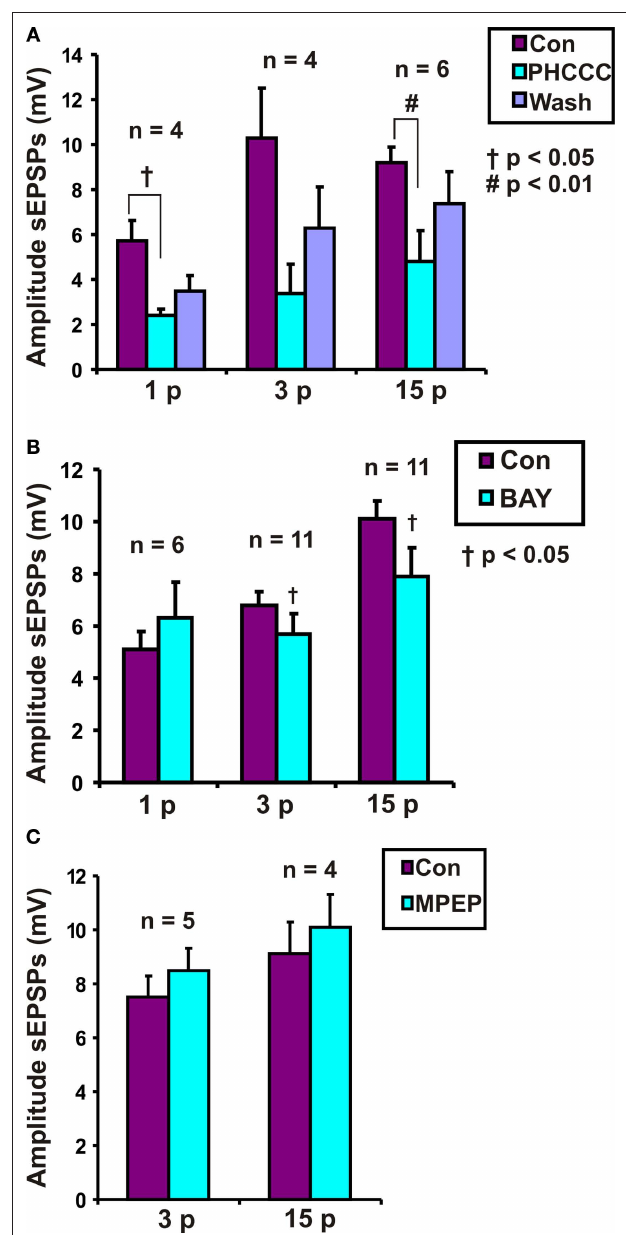
FiGuRE 4 | Effects of (A) PHCCC (30 μM), (B) BAY 36-7620 (10 μM) and (C) MPEP (10 μM) on slow EPSPs. Statistical analysis used two-tailed ANOVA for PHCCC and one-tailed paired t -tests for MPEP and BAY 36-7620. purinergic ( n = 4, p = 0.23) slow EPSPs ( Figure 4C ).